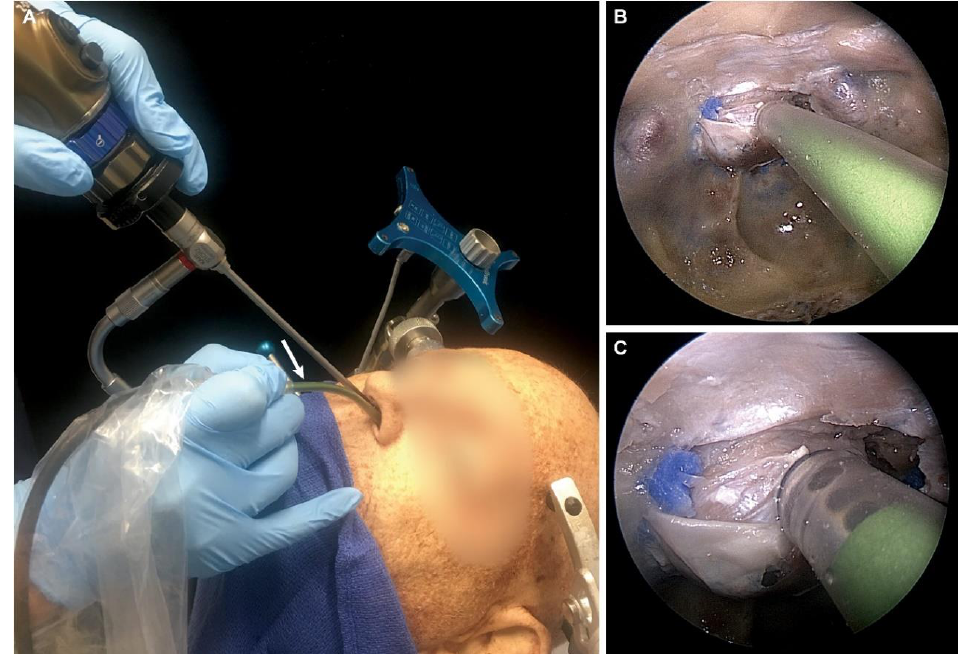
Figure 1. Position of confocal laser endomicroscopy (CLE) scanning probe in the endonasal transsphenoidal approach. ( A ) Overall position (arrow points to the CLE probe). ( B ) Far and ( C ) close-up endoscopic view of the tip of the probe in the sellar region. Used with permission from Barrow Neurological Institute, Phoenix, Arizona.